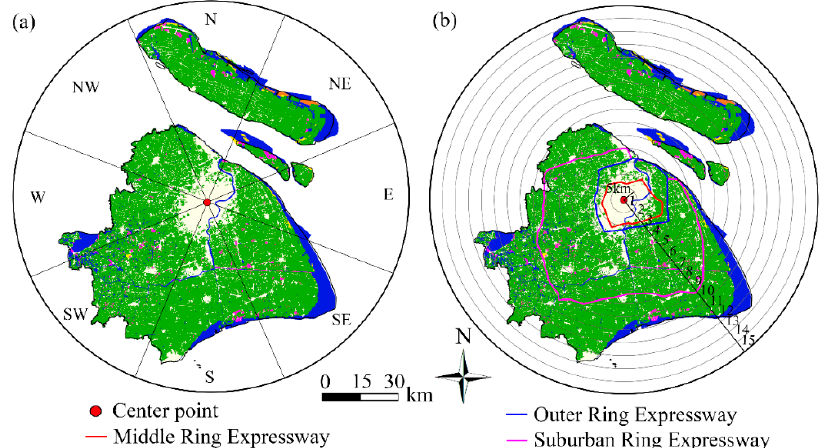
Figure 4. The eight directions and concentric belts for analyzing land-use patterns. ( a ) The spatial division of the eight directions; ( b ) the 15 concentric buffers centered at Shanghai’s city center. N: north; NE: northeast; E: east; SE: southeast; S: south; SW: southwest; W: west; NW: northwest.